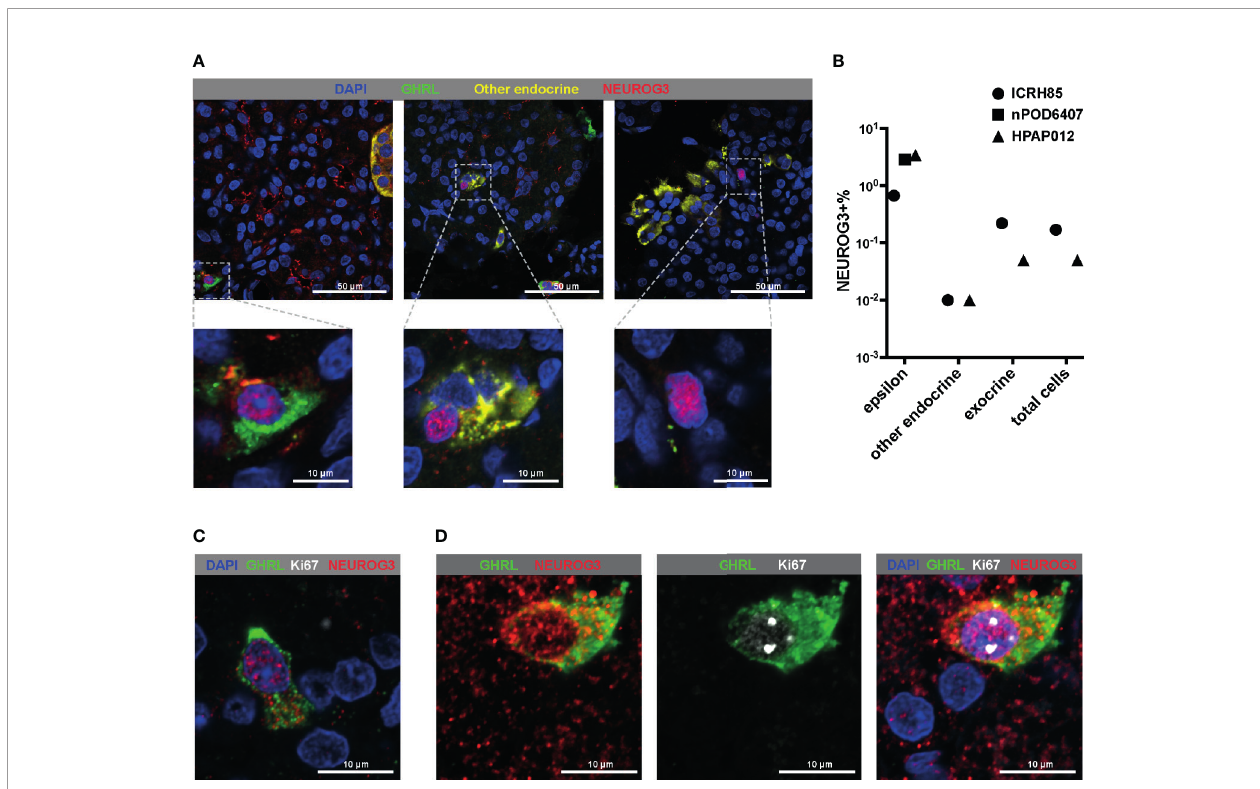
FIGURE 3 | Immuno fl uorescent staining con fi rms the high frequency of NEUROG3 expression within epsilon cells. (A, C, D) All images shown are a single confocal Z-section. (A) Representative images showing the positive nuclear labeling of NEUROG3 in epsilon cells (left panel), other endocrine cells (middle panel) and exocrine cells (right panel) in postnatal human pancreatic tissue sections. Zoomed-in views of boxed regions are shown at the bottom of each panel. Color channels are: DAPI, blue; GHRL, green; INS+GCG+SST (a combination of three antibodies against individual proteins), yellow; NEUROG3, red. (B) Quanti fi cations of NEUROG3+ cells in different populations. All cells from each section of the donor tissues were counted. Each data point represents aggregated results from one donor. “ Other endocrine ” corresponds to beta (INS+) or alpha (GCG+) or delta (SST+) cells. (C, D) Co-labeling of GHRL, NEUROG3 and Ki67. (C) The majority of NEUROG3+ cells are not proliferating. (D) in rare instances, coexpression of Ki67 and NEUROG3 can be observed. Color channels are: DAPI, blue; GHRL, green; Ki67, white; NEUROG3,